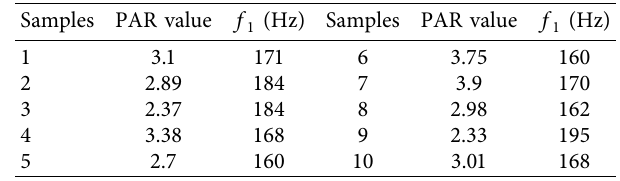
Figure 9: Acoustic signal analysis of Case 3: (a) acoustic signal of healthy EID-c, (b) acoustic signal of faulty EID-c, (c) time-varying specific loudness of healthy EID-c, (d) time-varying specific loudness of faulty EID-c, (e) time-varying loudness of healthy EID-c and faulty EID-c, and (f) time-varying loudness spectrum of healthy EID-c and faulty EID-c. Table 1: PAR of the time-varying loudness spectra of healthy EIDs. Table 2: PAR of the time-varying loudness spectra of faulty